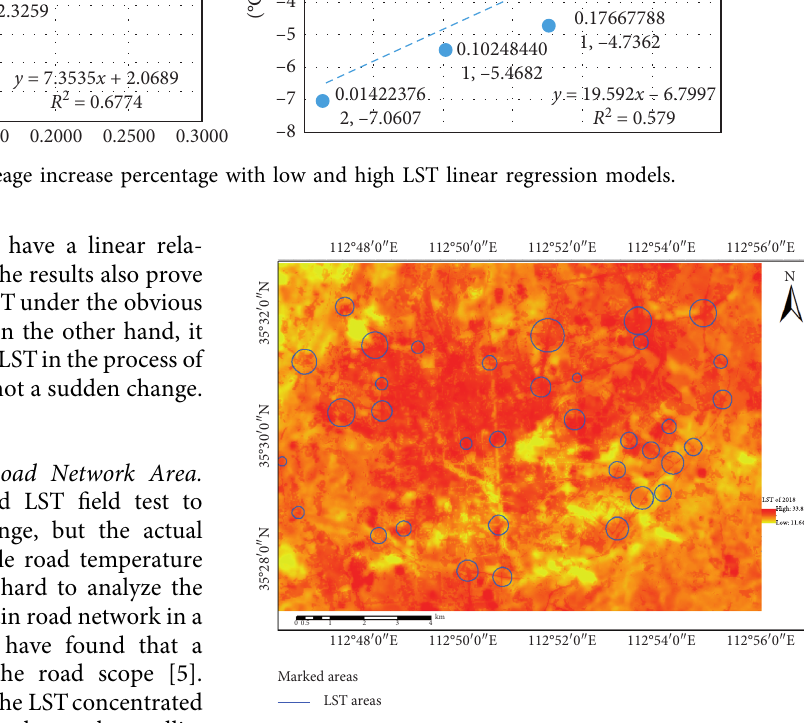
Figure 7: LST impact scope of road (different size circles indicate different LST affected areas). Analysis of LST radiation range on road network